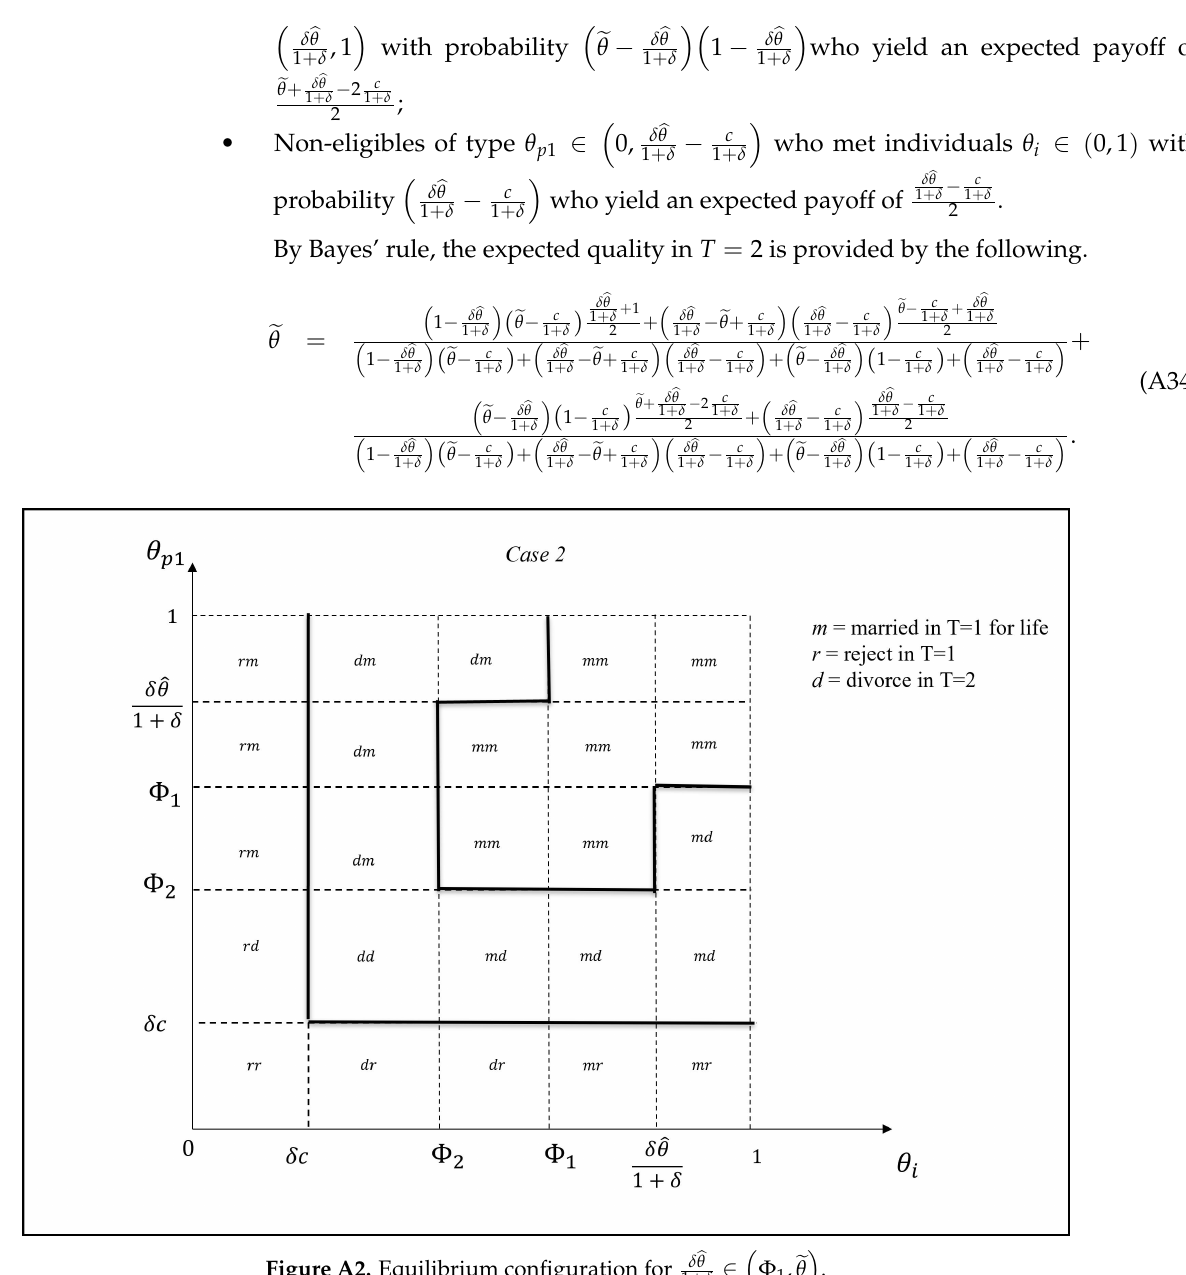
Figure A2. Equilibrium configuration for δ (cid:98) θ